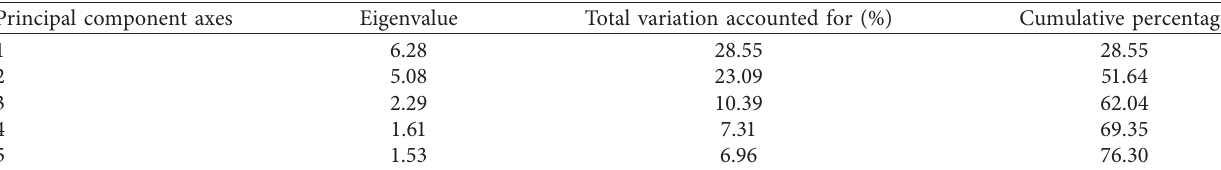
Table 4: Eigenvalues, percentage of total variation accounted for, and cumulative percentage by the first six principal component axes of okra.